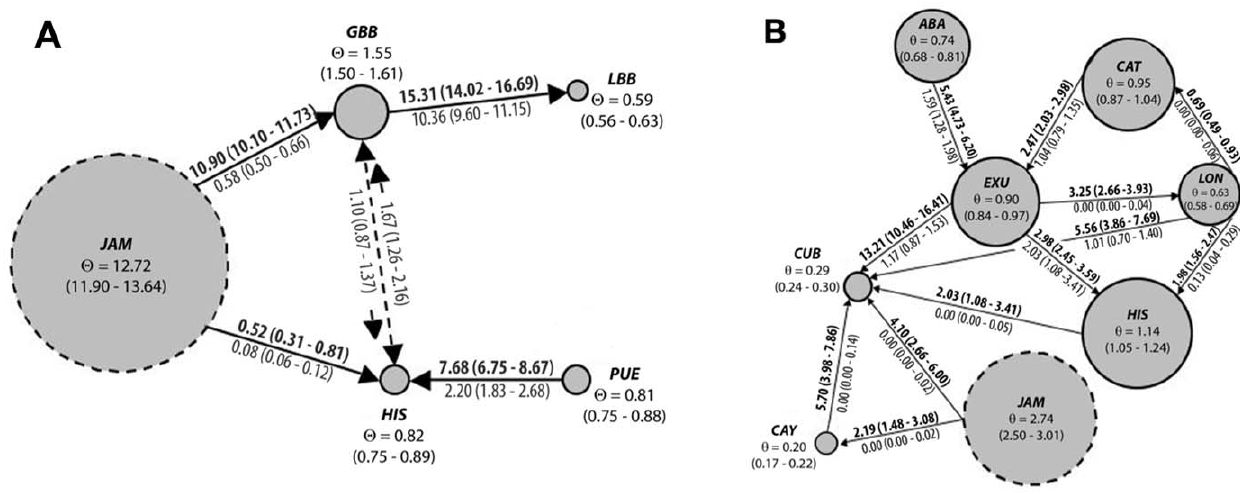
Figure 5. Estimated migration rates and estimated h . Directional gene flow (plus 95% confidence intervals) and estimated h between genetic populations of (a) Erophylla and (b) M. waterhousii based on estimates from MIGRATE (see Fig. 1 for location abbreviations). Solid arrows represent significantly different (asymmetric) values, and bold values correspond to gene flow in the direction indicated. Dashed arrow represents symmetric gene flow for Erophylla but only instances of asymmetric gene flow are shown for M. waterhousii because of space limitations. Full results for both lineages can be found in Text S1, A. Circle sizes represent relative population size ( h ) except for JAM, which reflects h /2.